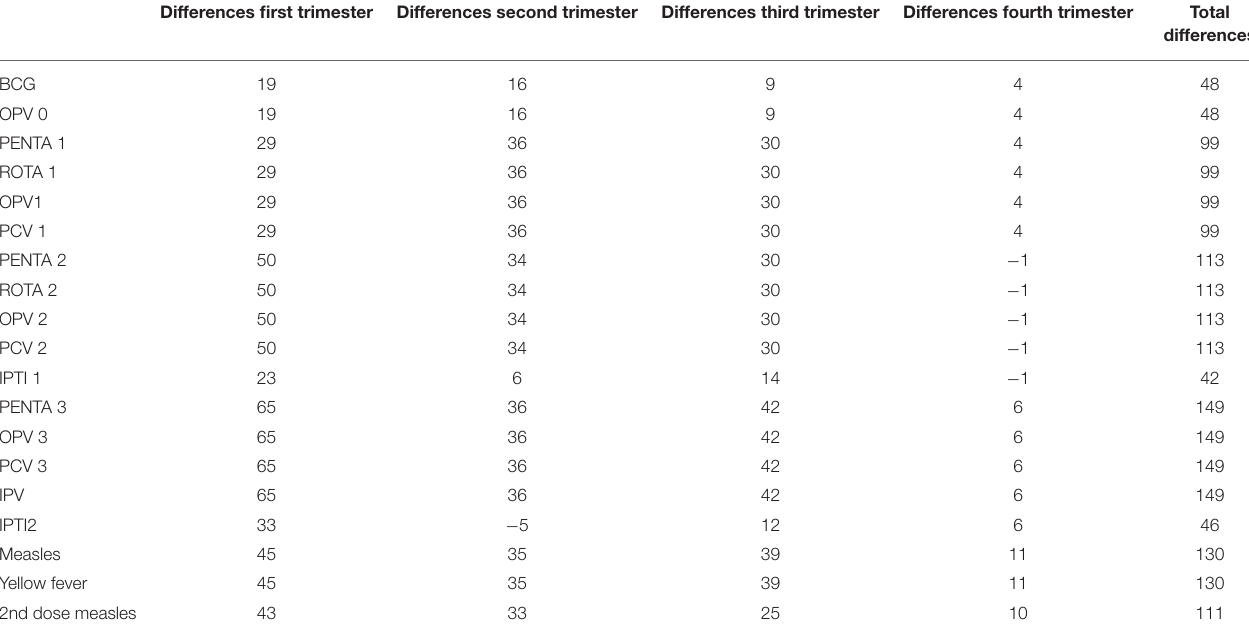
TABLE 2 | Differences in the number of vaccinations performed per trimester in the 2 years. Differences first trimester Differences second trimester Differences third trimester Differences fourth